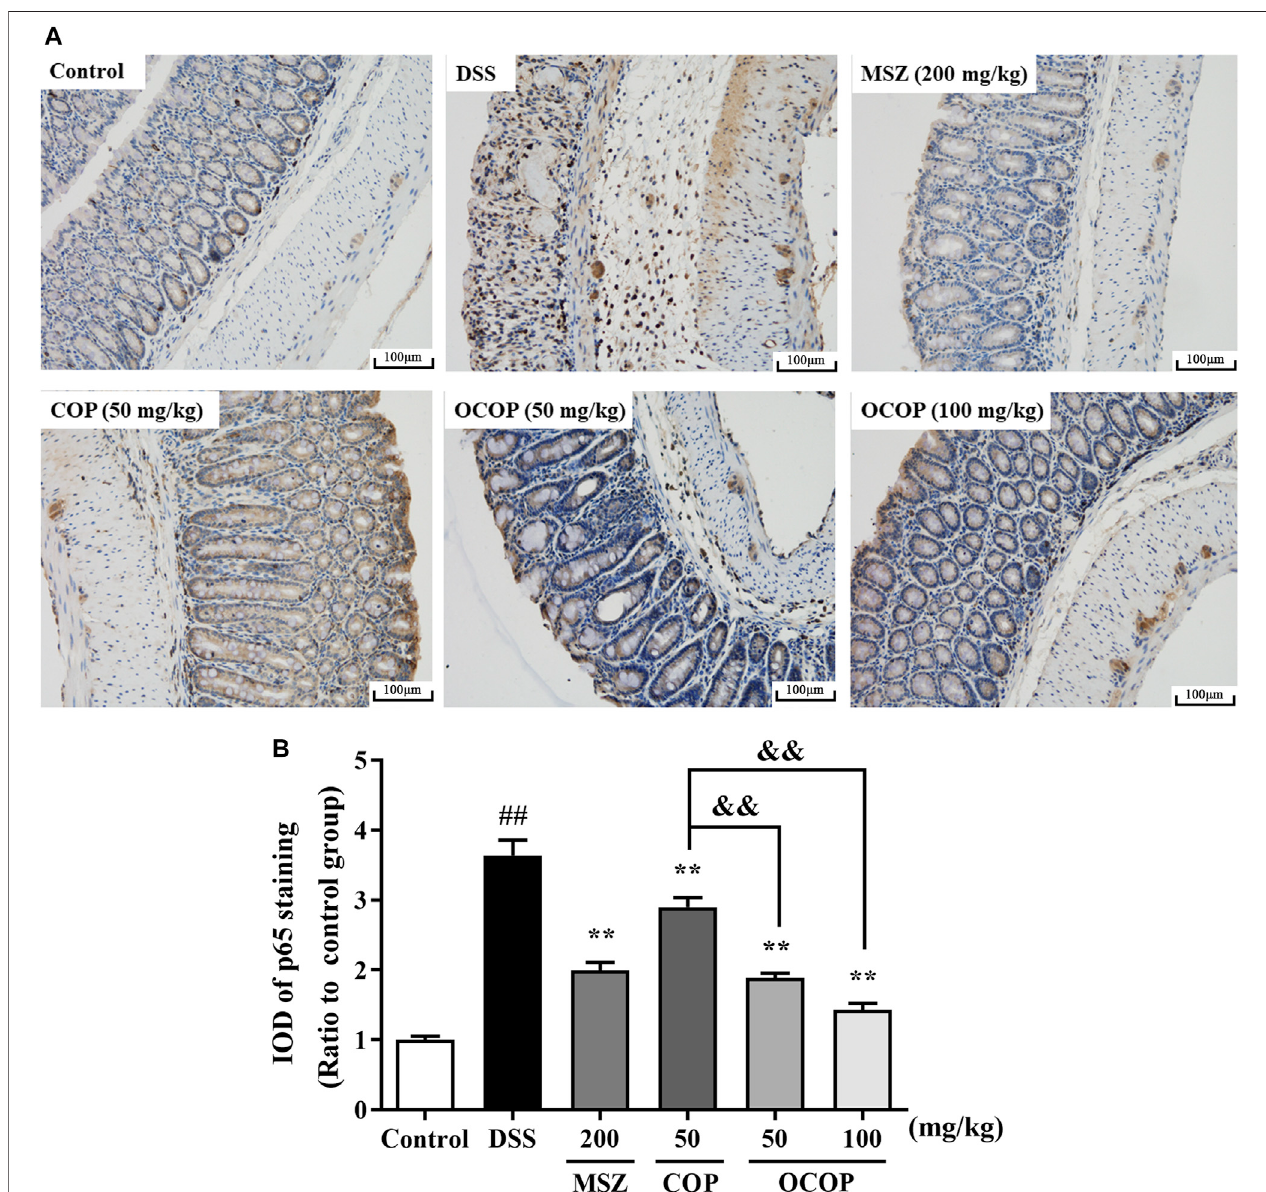
FIGURE 6 | (A) Representative photographs of p65 immunohistochemical staining (magni fi cation × 200) (B) Integrated optical density of p65. Data are expressed as the means ± SD (n (cid:2) 3). # p < 0.05, ## p < 0.01 vs. control group; * p < 0.05, ** p < 0.01 vs. DSS group; & p < 0.05, && p < 0.01 vs. COP group.